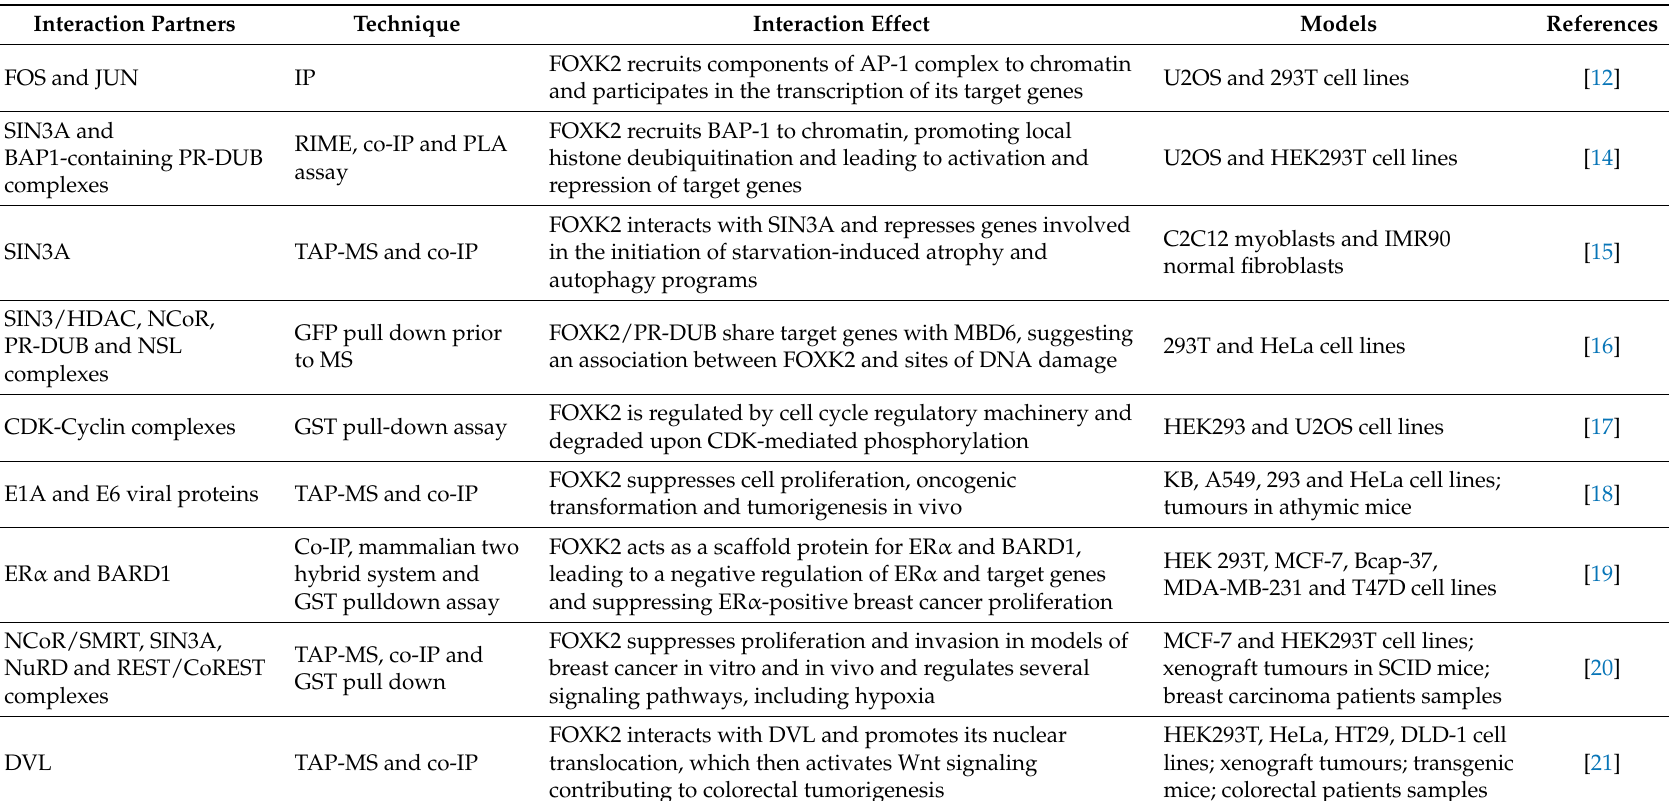
Table 1. FOXK2 interaction